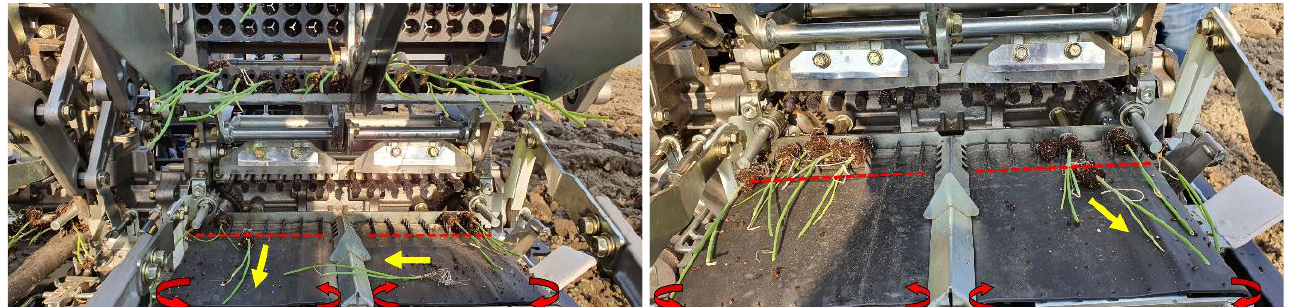
Figure 5. Onion seedlings were split from the track of the conveyor belt due to high vibrational exposure. The dotted line indicates the track position, and the arrow indicates the splitting direc- tions.